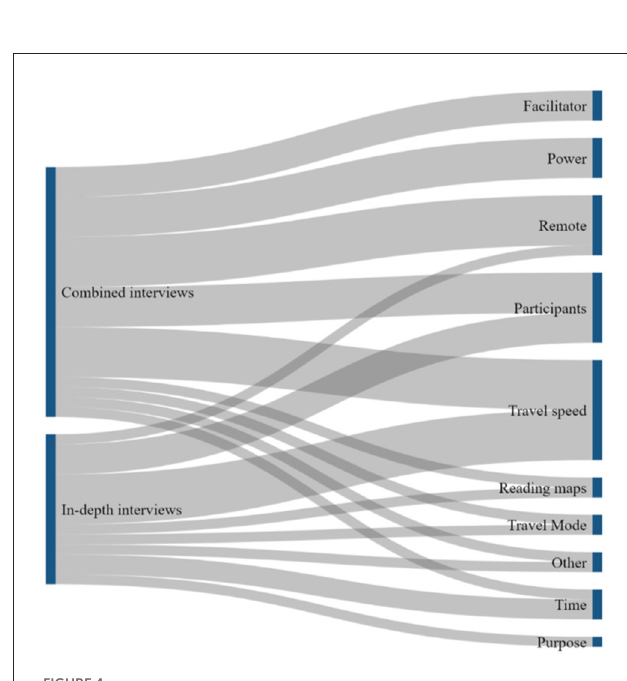
FIGURE4 Sankey diagrams showing which challenges were most frequently emphasized by the interview